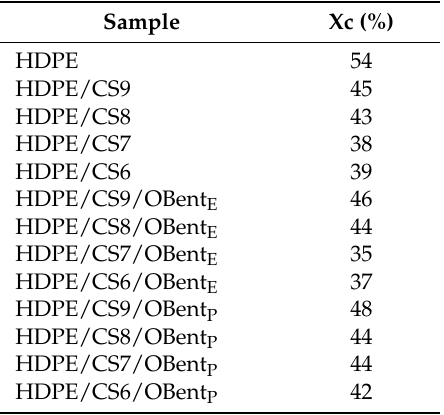
Table 1. Degree of crystallinity (Xc) of HDPE and HDPE/CS formulations, as calculated by XRD.